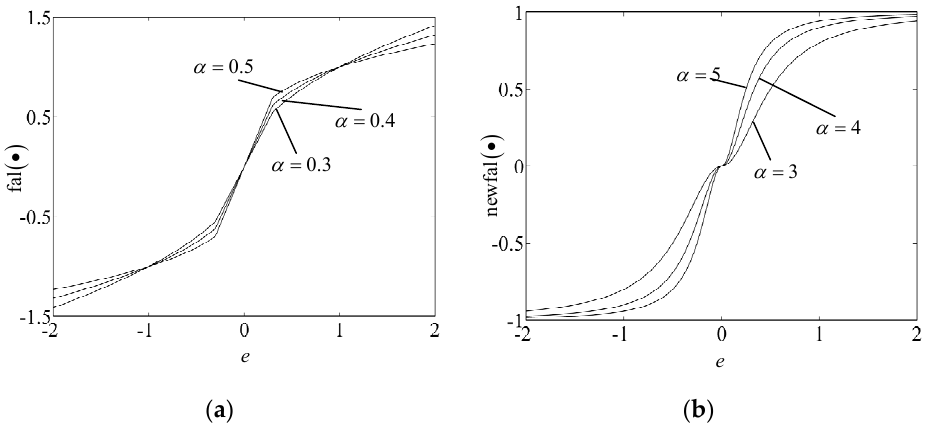
Figure 4. Function characteristic curve: ( a ) the characteristic curve of function fal( • ) varied with α when δ = 0.3; and ( b ) the characteristic curve of function newfal( • )varied with α when γ = 1, β = 1, 2 .